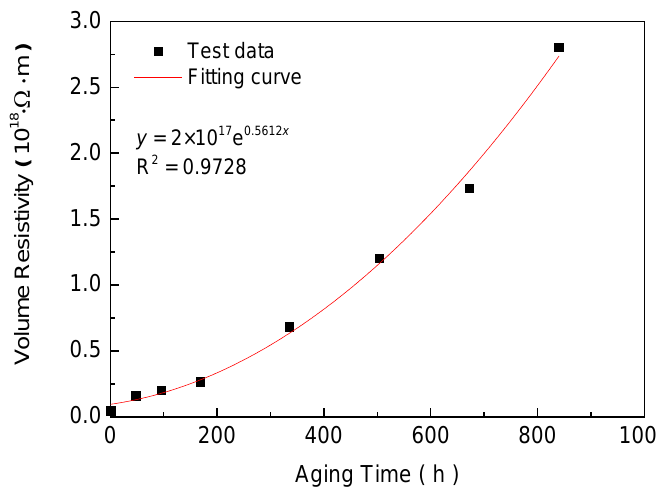
Figure 4. Variation of volumetric resistivity versus the aging time.